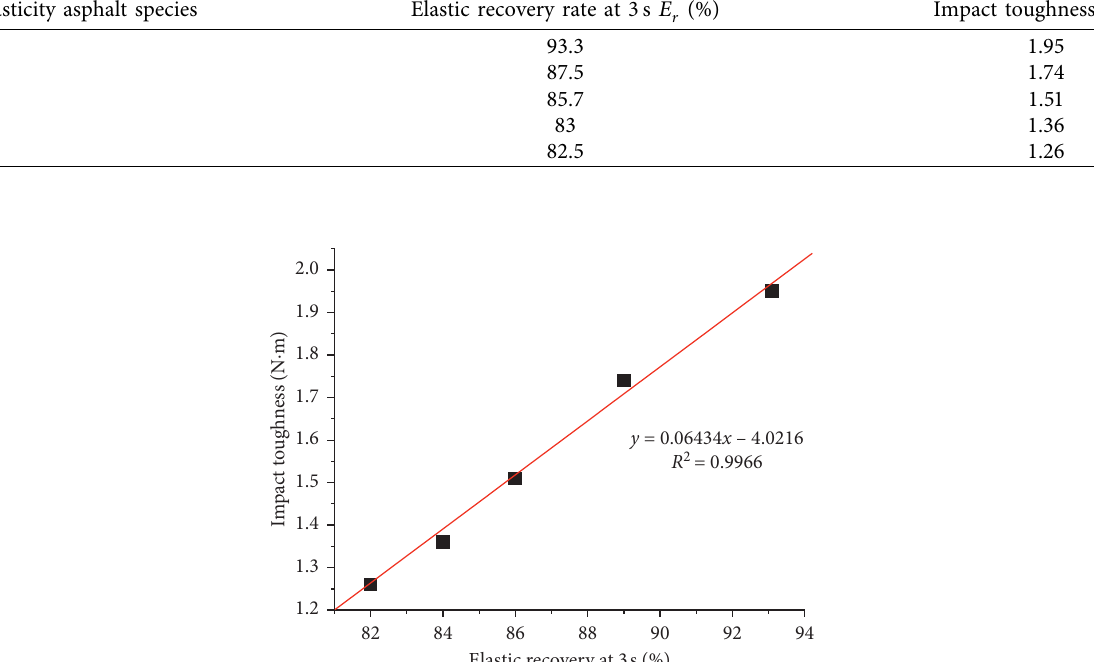
Table 4: Elastic recovery and impact toughness OF high-elasticity modified asphalt. High-elasticity asphalt species